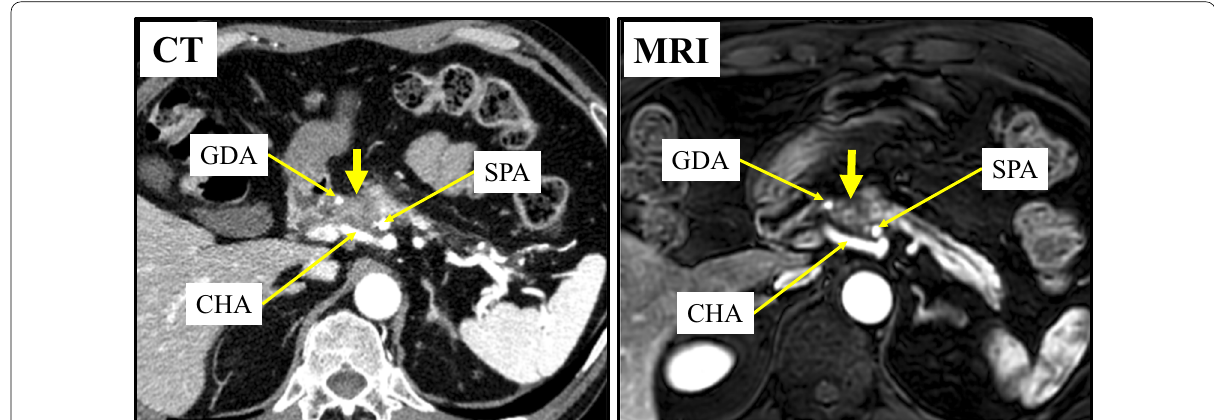
Fig. 2 Contrast-enhanced computed tomography (CT) and magnetic resonance imaging (MRI) after two cycles of gemcitabine plus nab-paclitaxel therapy showing substantial shrinkage of the tumor (yellow arrow). Although the tumor is still in contact with the GDA, CHA, and SPA on CT, MRI shows a gap between the tumor and arteries. CHA common hepatic artery, GDA gastroduodenal artery, SPA splenic